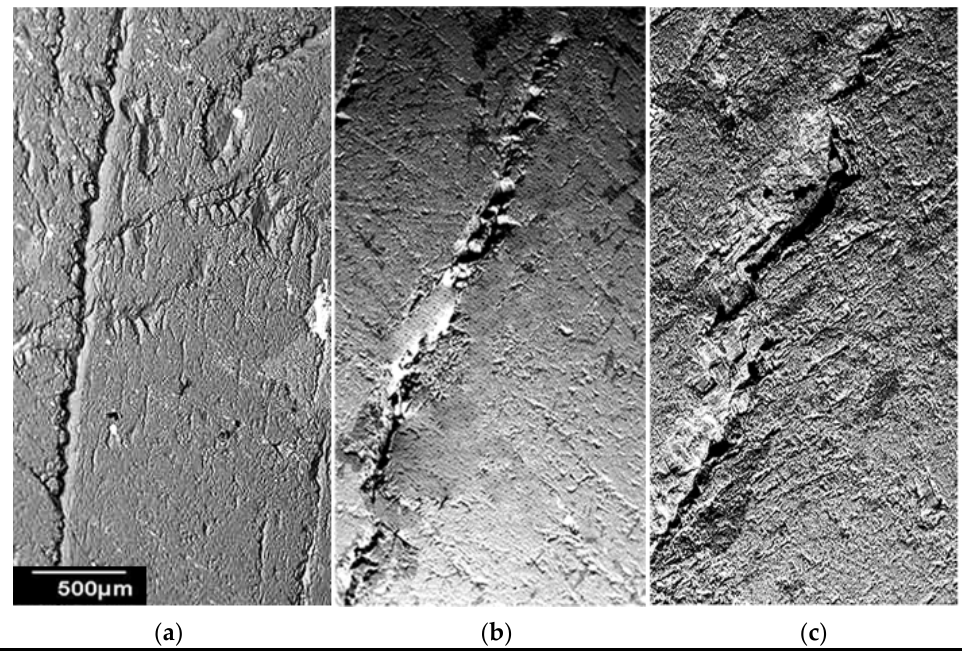
Figure 7. Growth of a crack in a dolomitic limestone sample during repeated freezing and thawing under laboratory conditions: ( a ) crack in the soil sample prior to laboratory testing; ( b ) crack after 520 cycles of alternate freezing and thawing of the sample; ( c ) crack after 990 cycles of alternate freezing and thawing of the sample.